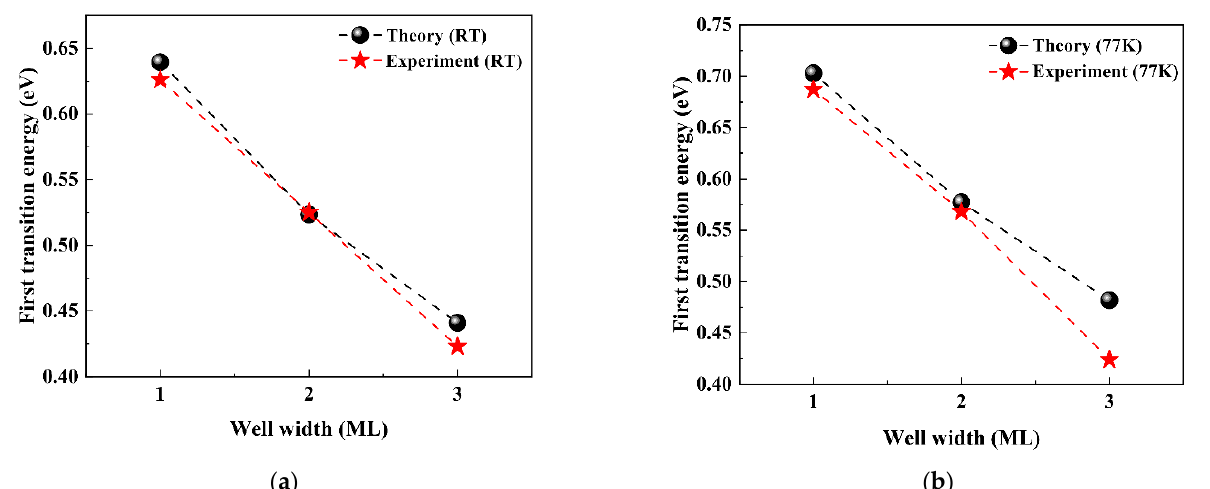
Figure 7. Theoretical and experimental results of first transition energies for 1, 2, and 3 MLs of InAs/GaSb MQW for ( a ) 300 K and ( b ) 77 K.